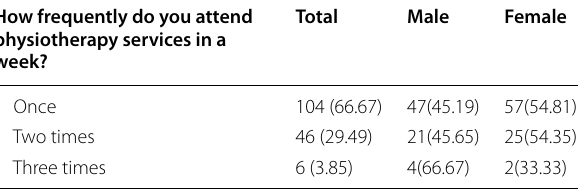
Table 5 The frequency physiotherapy patients and PWD